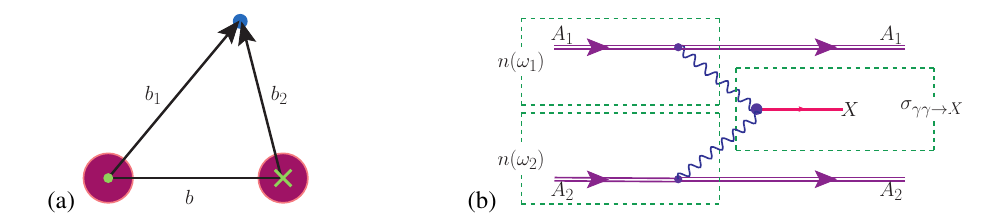
Figure 3. (a) A view perpendicular to the direction of two ion motion. (b) Feynman diagram for AA → AA X process.